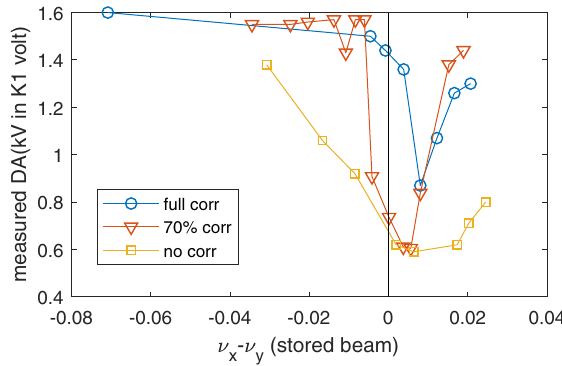
FIG. 3. Dynamic aperture vs tune separation for the three coupling